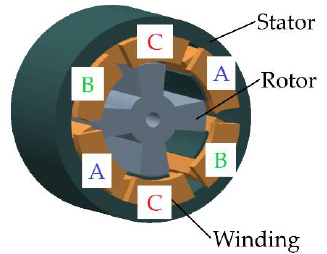
Figure 1. Three-phase 4/6 pole SRM structure.